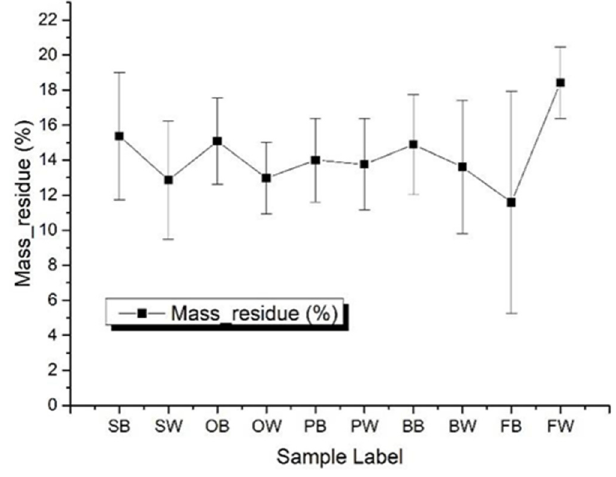
Figure 5. Residual mass percentage of each sample averaged by all heating rates with Method A.